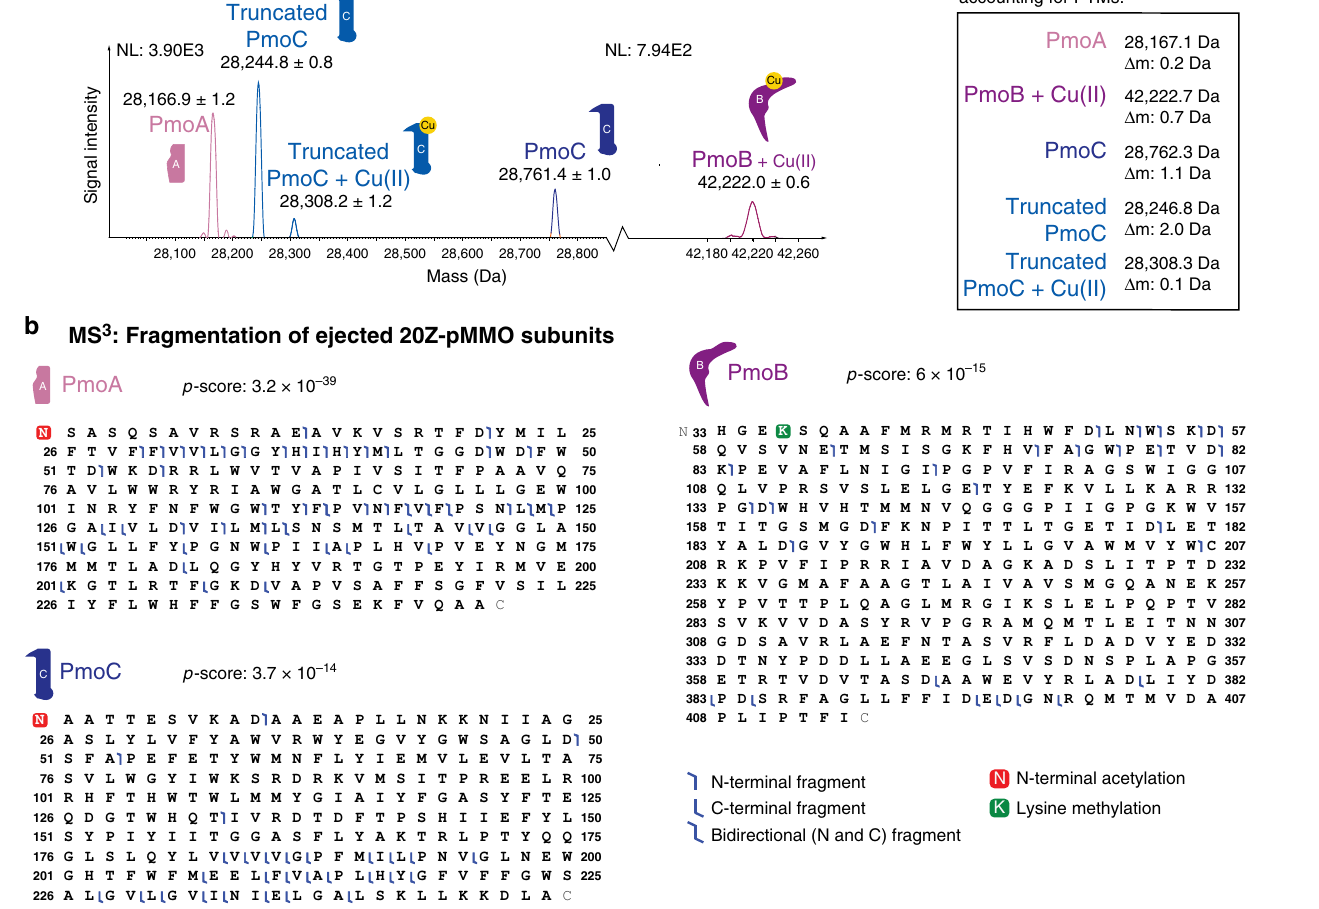
Fig. 5 nTDMS analysis of 20Z-pMMO in MSP2N2 nanodiscs. a Deconvoluted MS 2 showing detection of 20Z-pMMO subunit masses upon ejection from the nanodisc-pMMO complex. The panel on the right contains the theoretical masses of the subunits, accounting for the modi fi cations characterized by tandem MS. b Graphical fragment maps of pMMO subunits derived from the MS 3 step in the nTDMS platform. Fragments are depicted as blue fl ags in the graphical fragment maps, indicating which regions of the protein sequence can be accounted for in mass by the fragments. The pMMO subunits were found to be modi fi ed by N-terminal acetylation (PmoA and PmoC), N-terminal truncation (PmoC), and lysine methylation (PmoB). The graphical fragment map of PmoB begins at residue His 33, showing cleavage of the known N-terminal signal